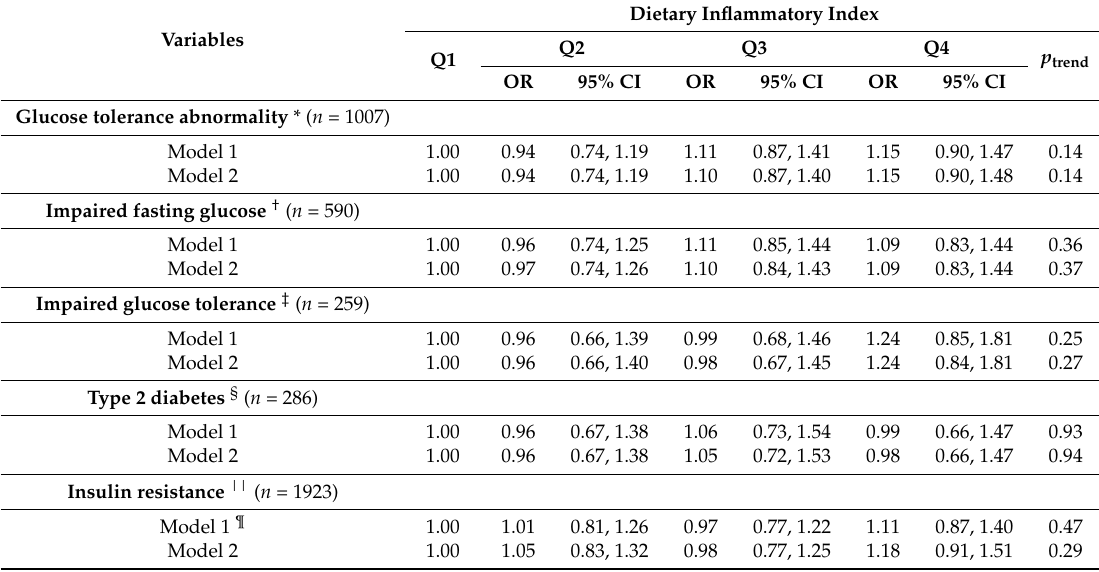
Table 4. Odds ratios (95% CI) for glucose intolerance outcomes according to the quartiles of the dietary inflammatory Index (DII).